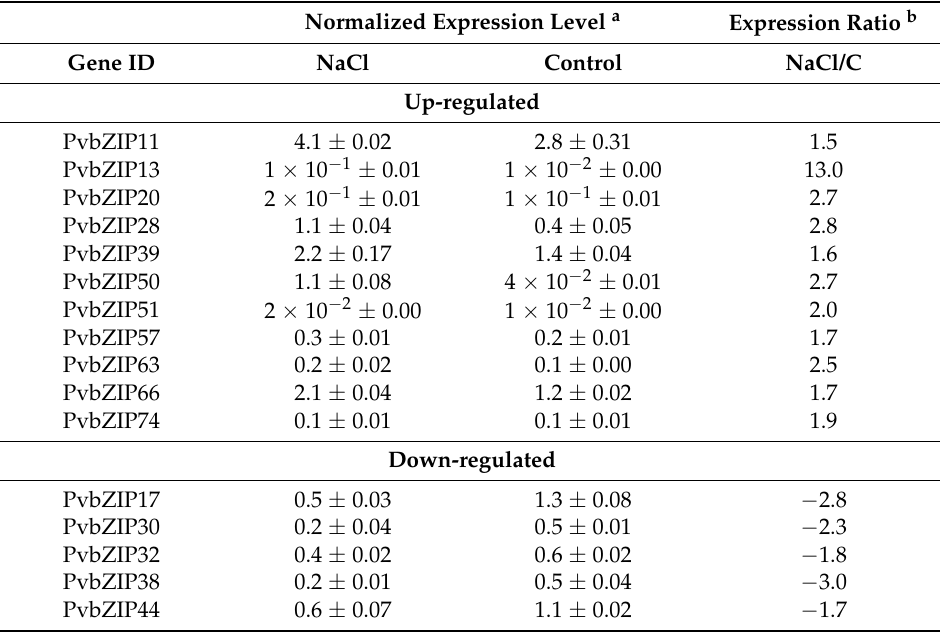
Table 1. P. vulgaris bZIP ( PvbZIP ) genes significantly differentially expressed ( ≥ 1.5-fold) in roots of NaCl-stressed fertilized plants identified by real-time